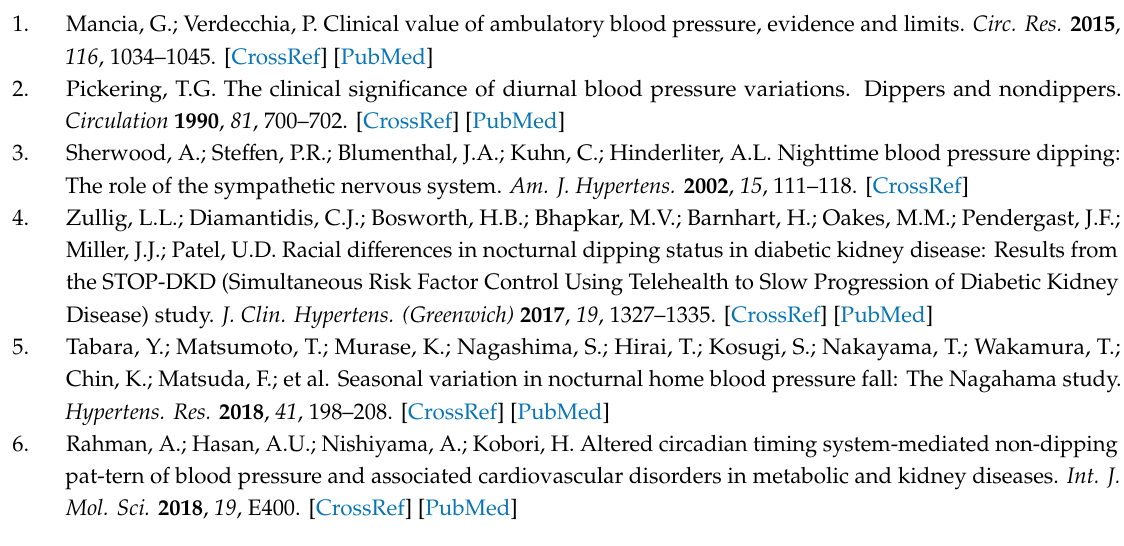
Table S1: Data on definition of dipping pattern, night-time period, interval of night-time blood pressure measurements and type of ambulatory blood pressure monitoring devices provided by the selected 14